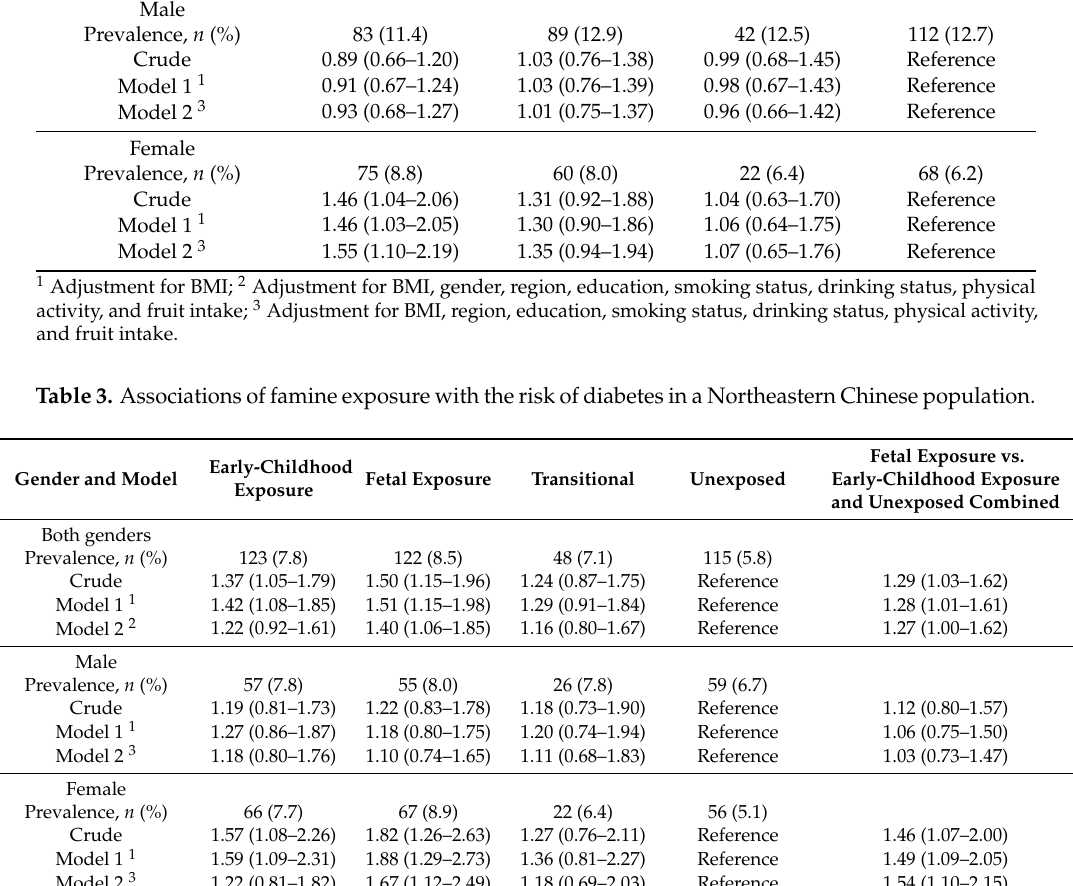
Table 2. Association of famine exposure with risk of hyperglycemia in Northeastern Chinese population. Gender and Model